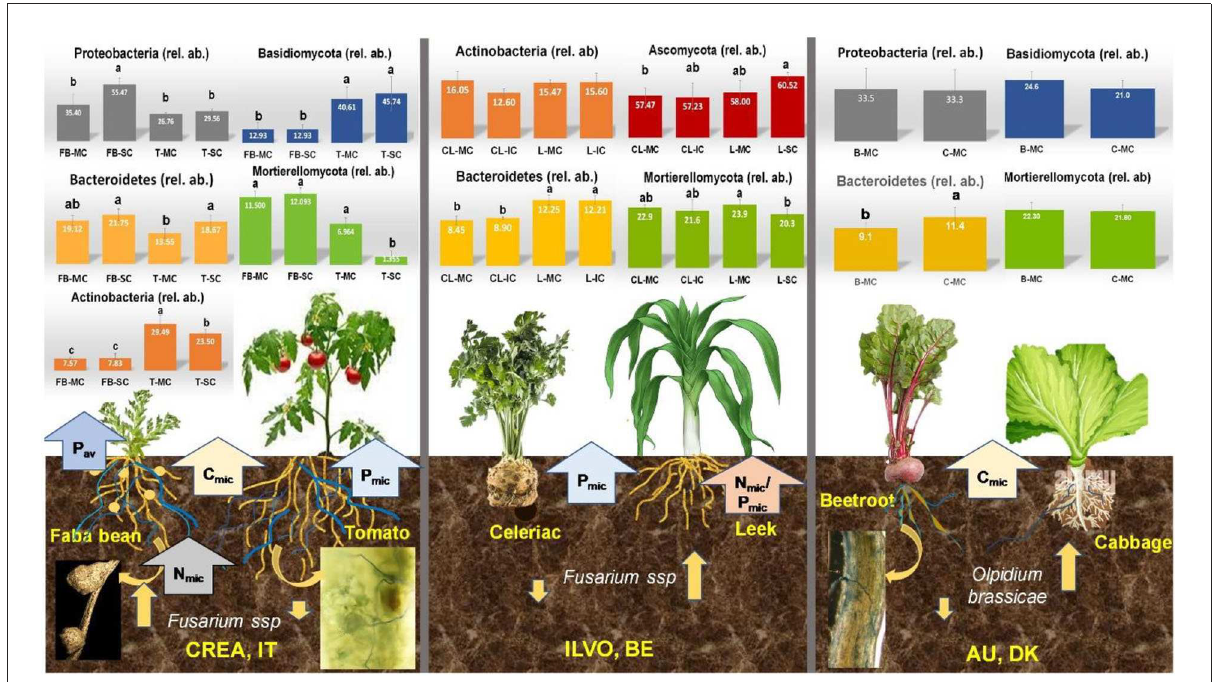
FIGURE10 Synthesis of main relevant results obtained at CREA (IT), ILVO (BE), and AU (DK) experimental sites on belowground functional diversity. Bars denote standard errors of the mean. Different letters are significantly different at p < 0.05 (Tukey test). MC, monocropping; SC, strip-cropping; IC,